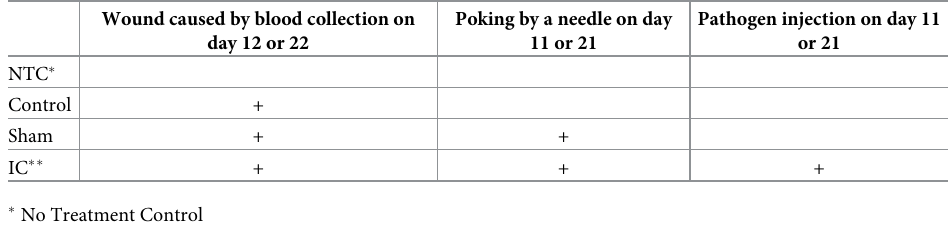
Table 2. List of treatments given to control, Sham, and IC